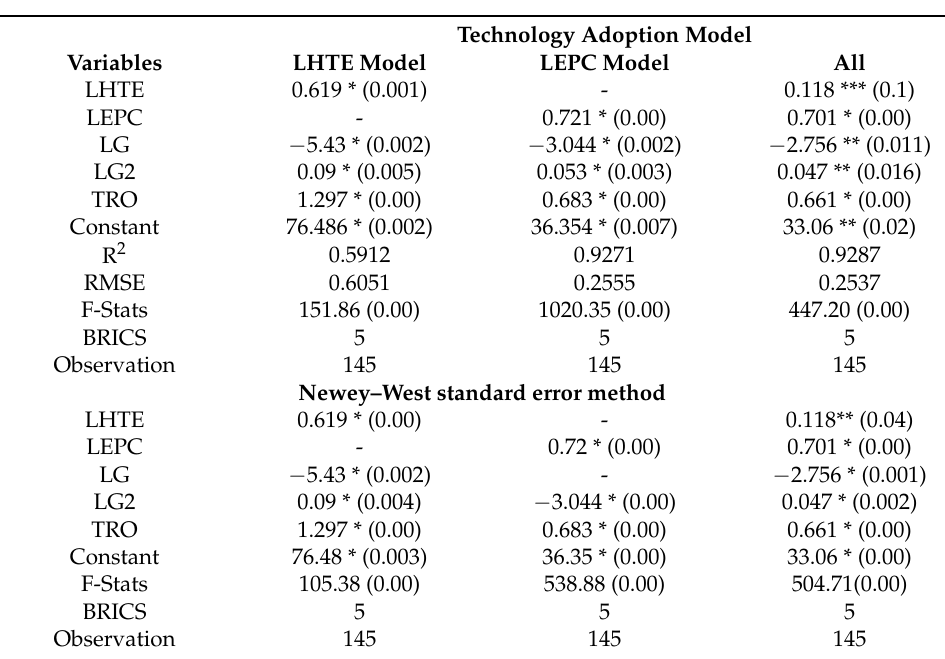
Table 6. Technology adoption